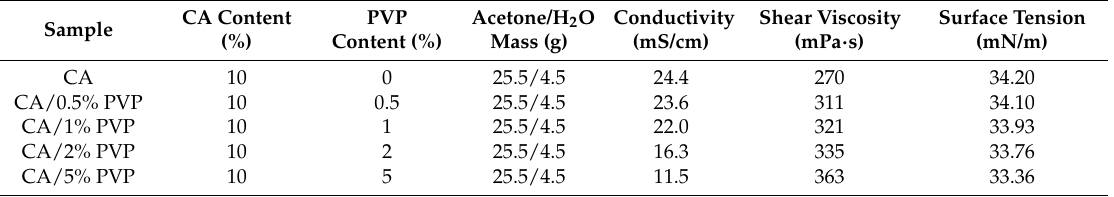
Table 1. The properties of electrospun cellulose acetate (CA)/polyvinylpyrrolidone (PVP)